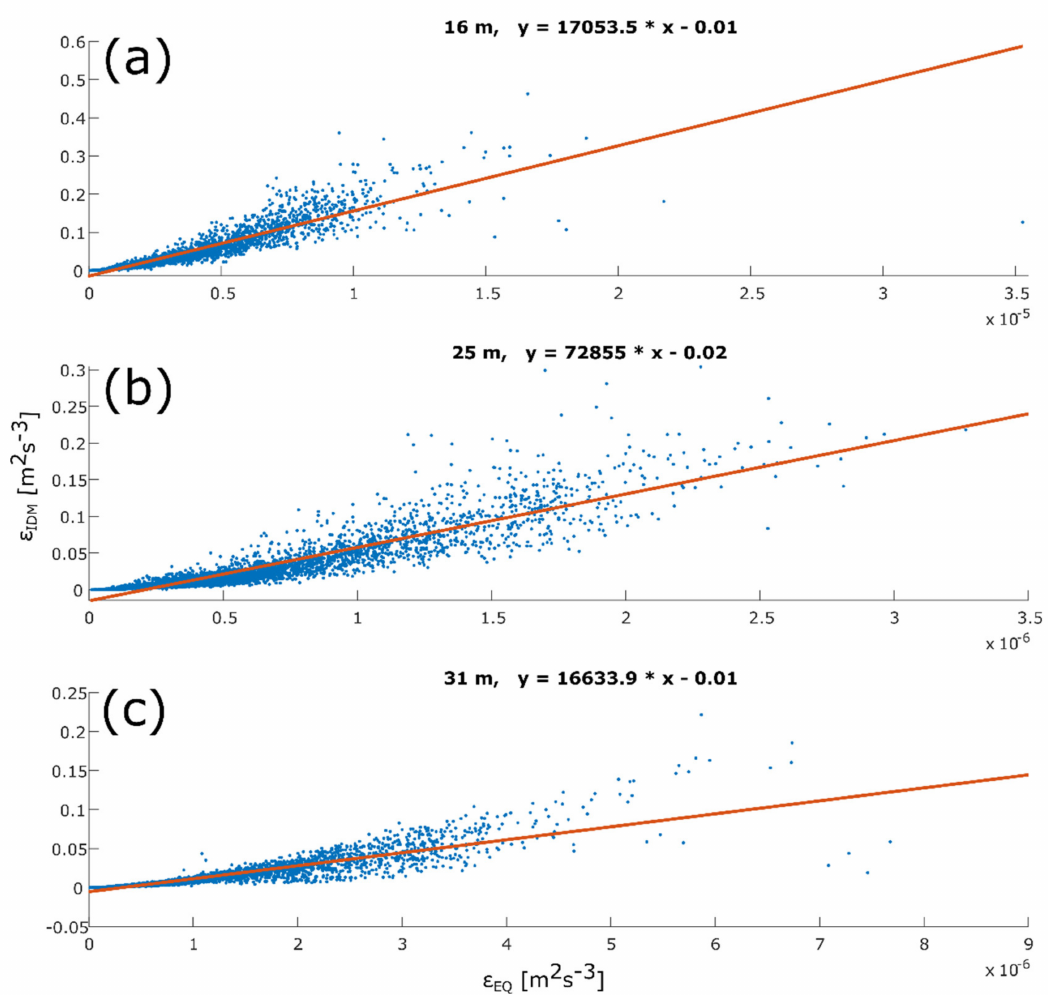
Figure 4. Linear regression between VD obtained by IDM ( ε IDM ) and by direct approach ( ε EQ ) for all bora episodes and at ( a ) 16 m, ( b ) 25 m and ( c ) 31 m mid − levels. The intercept y and the slope term are given in the